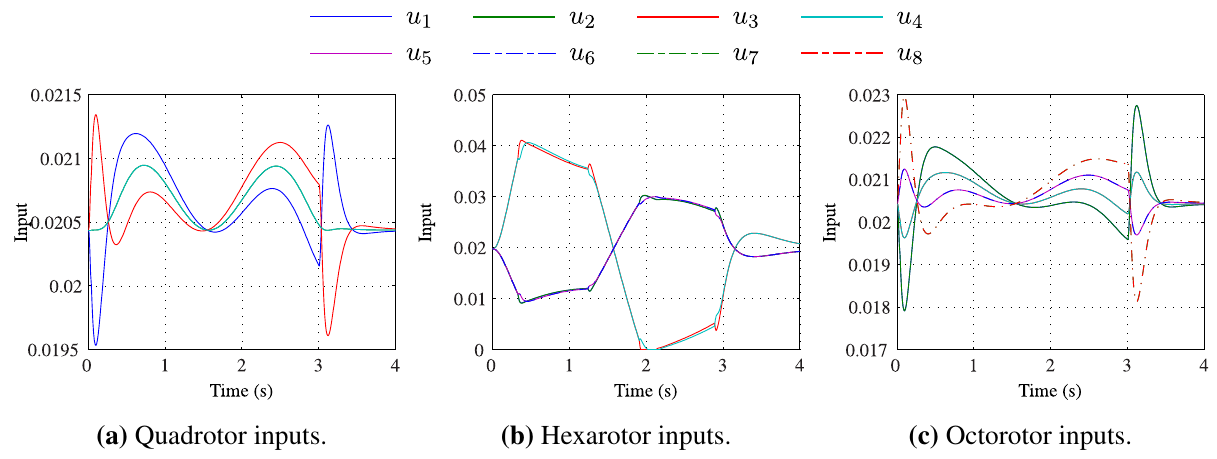
Figure 12. Rotor input histories for each configuration while performing a fast horizontal translation.